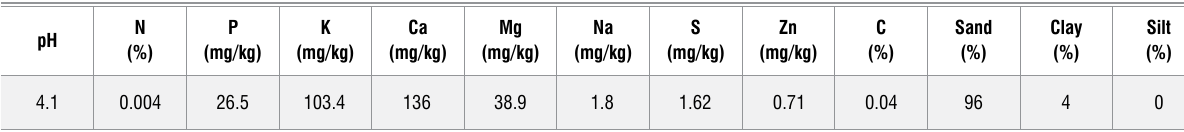
Fertiliser applied over two years to two wheat cultivars in four treatments in a greenhouse experiment Chemical (mg/L)